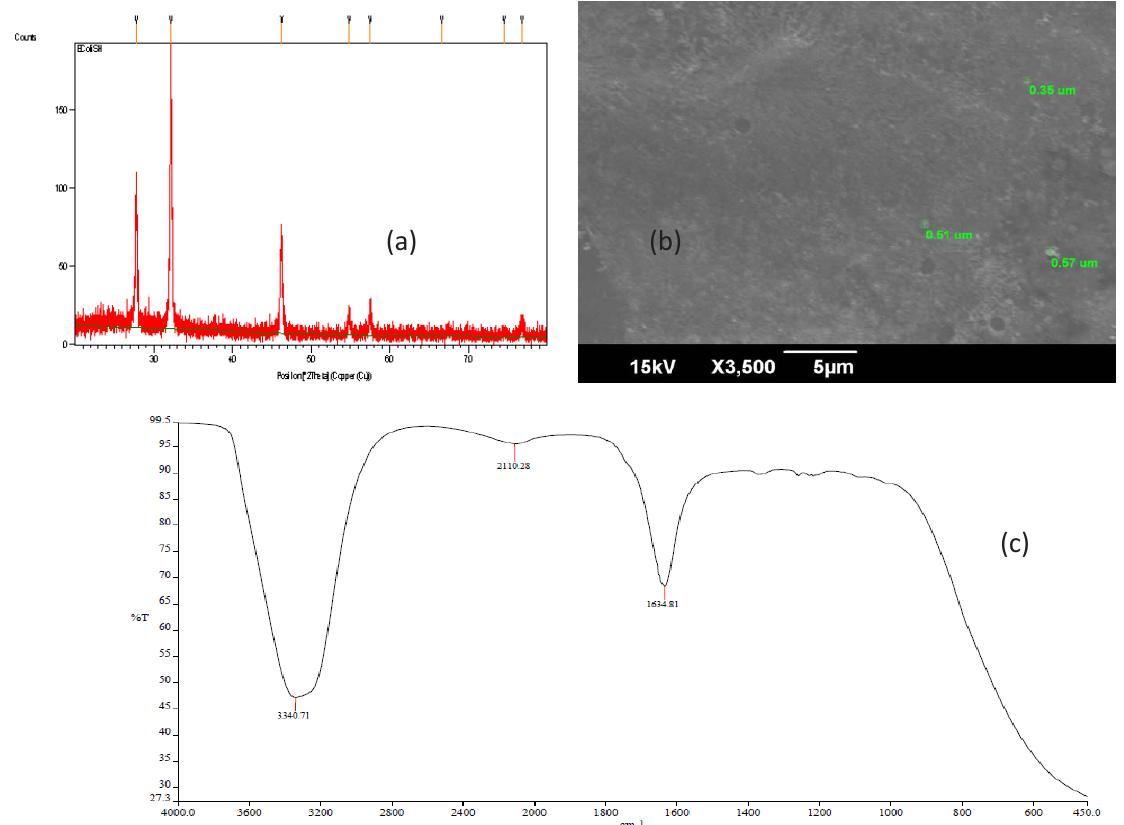
Fig. 6. Characterization of siver nanoparticle synthesised from supernatant of Escherichia coli: (a) XRD pattern (b) SEM image (c) FTIR spectra.